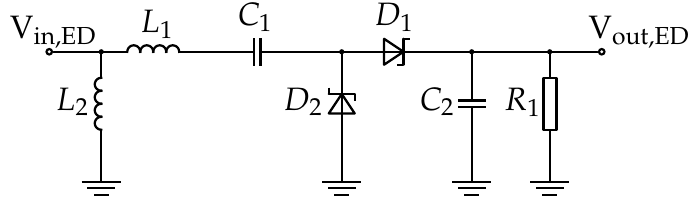
Figure 9. Schematic of the envelope